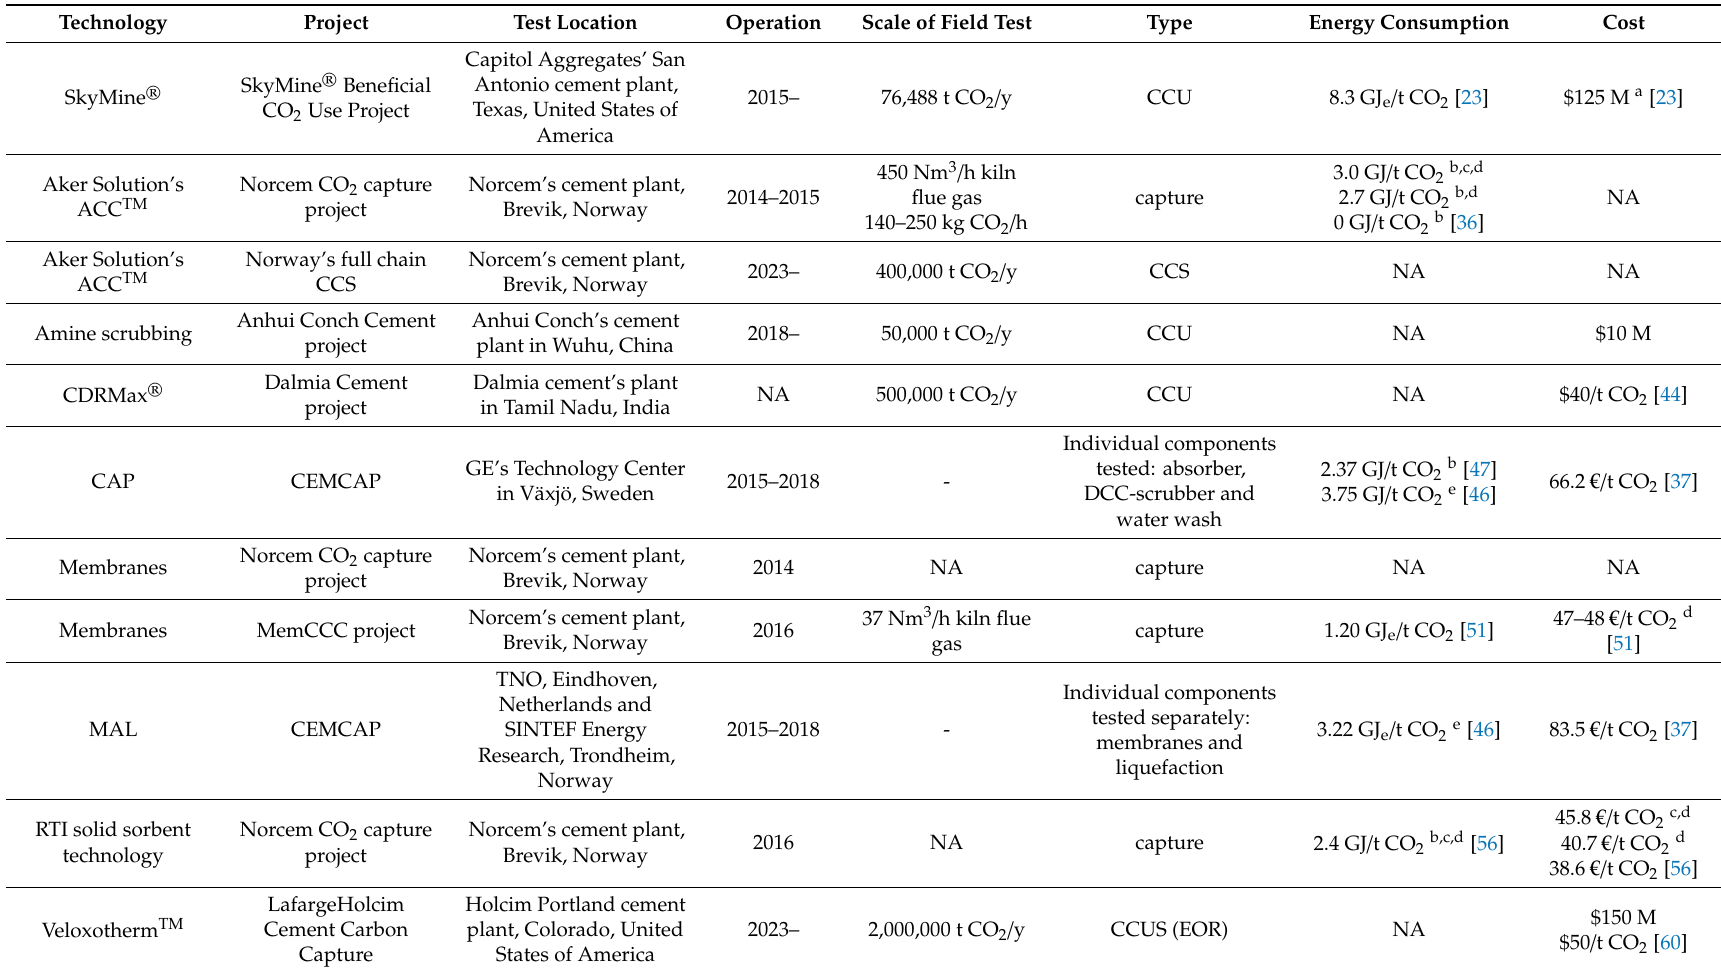
Table 1. Summary of carbon capture technologies evaluated and planned in the cement